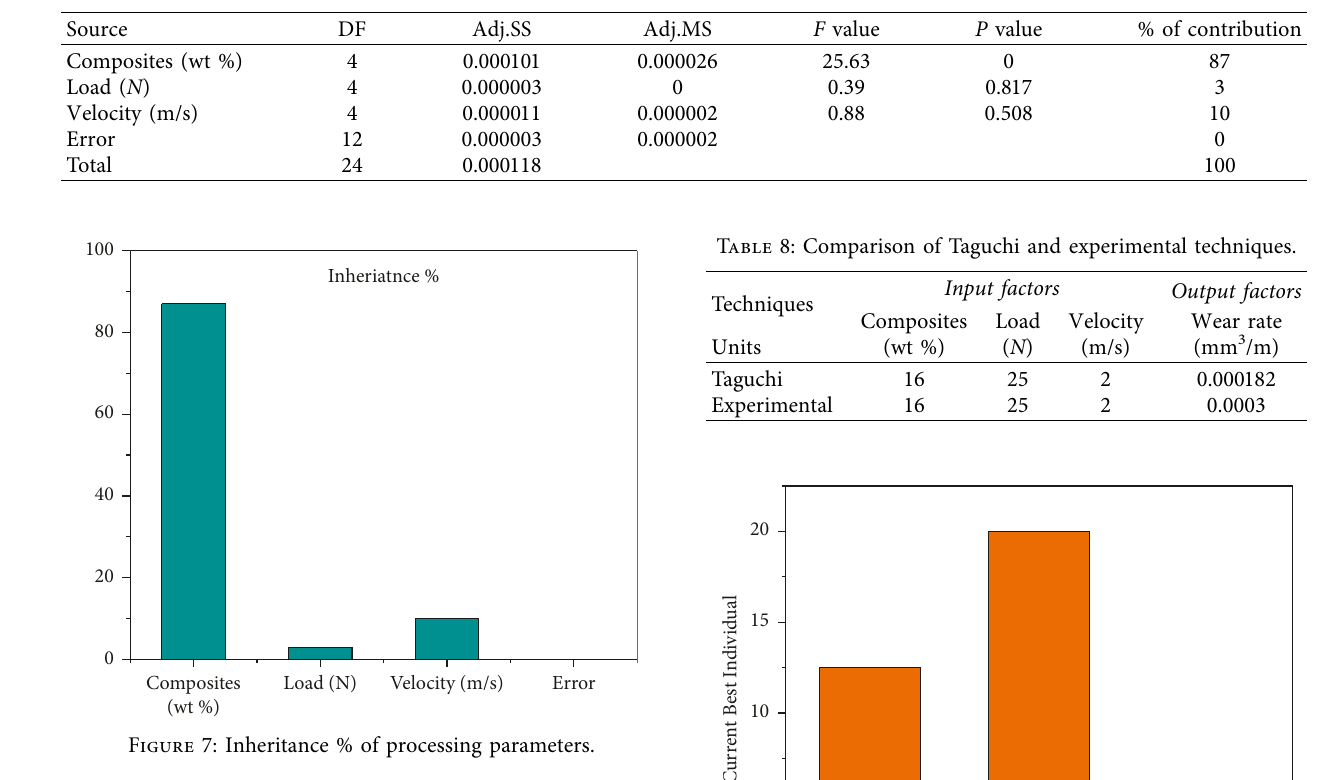
Figure 6: Main effect plot for the wear rate. Table 7: ANOVA wear rate.